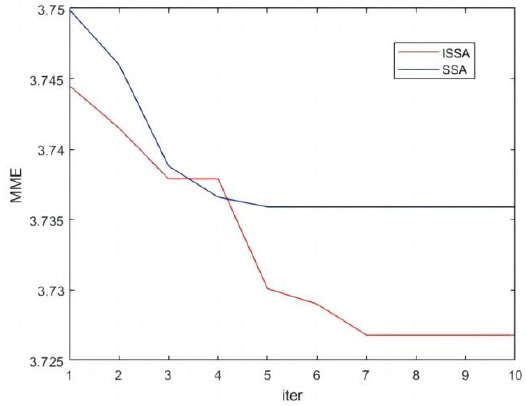
Figure 6. Minimum mean envelope entropy iteration curve.